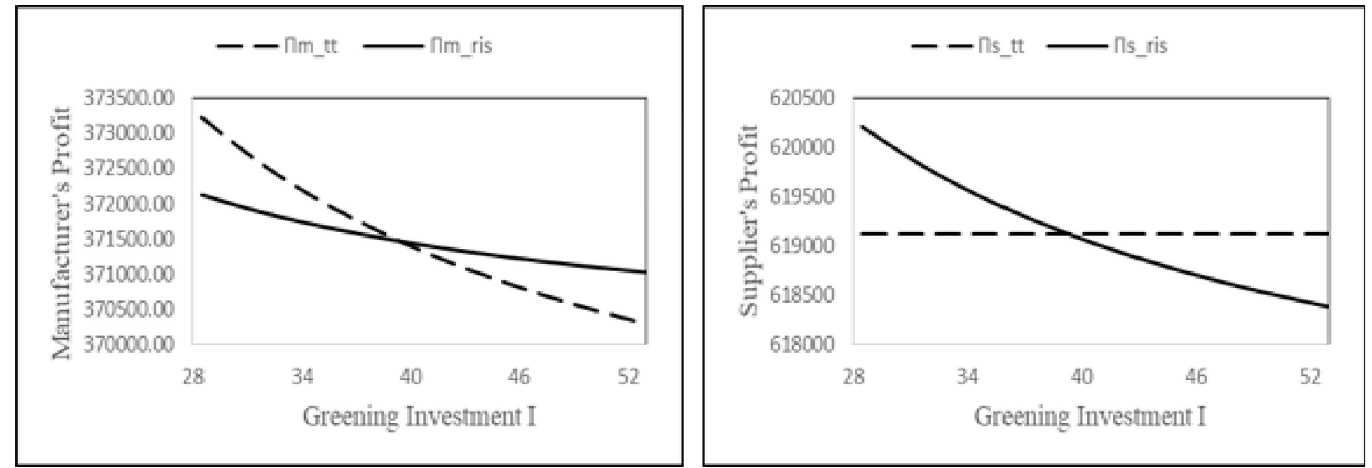
Fig 1. Comparison of manufacturer’s and supplier’s profit in two contracts w.r.t. the greening investment.